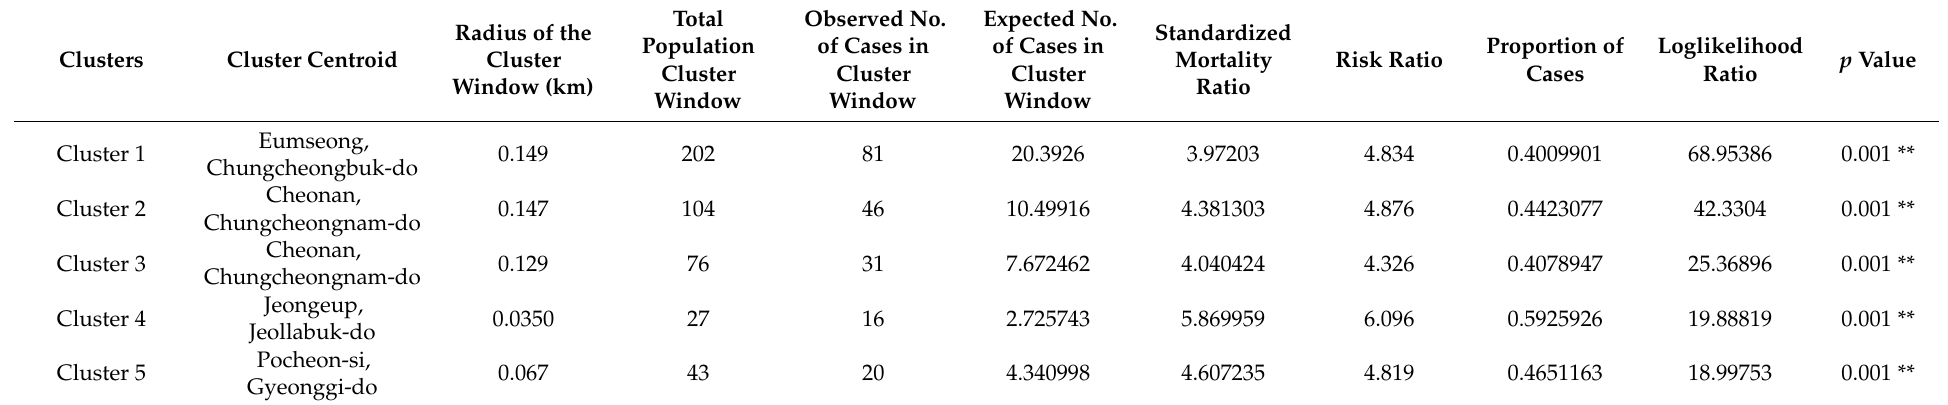
Table 1. Summary of five significant clusters identified in the HPAI H5N6 epidemic in South Korean poultry farms during 2016–2017. (**) represent the degree of level of